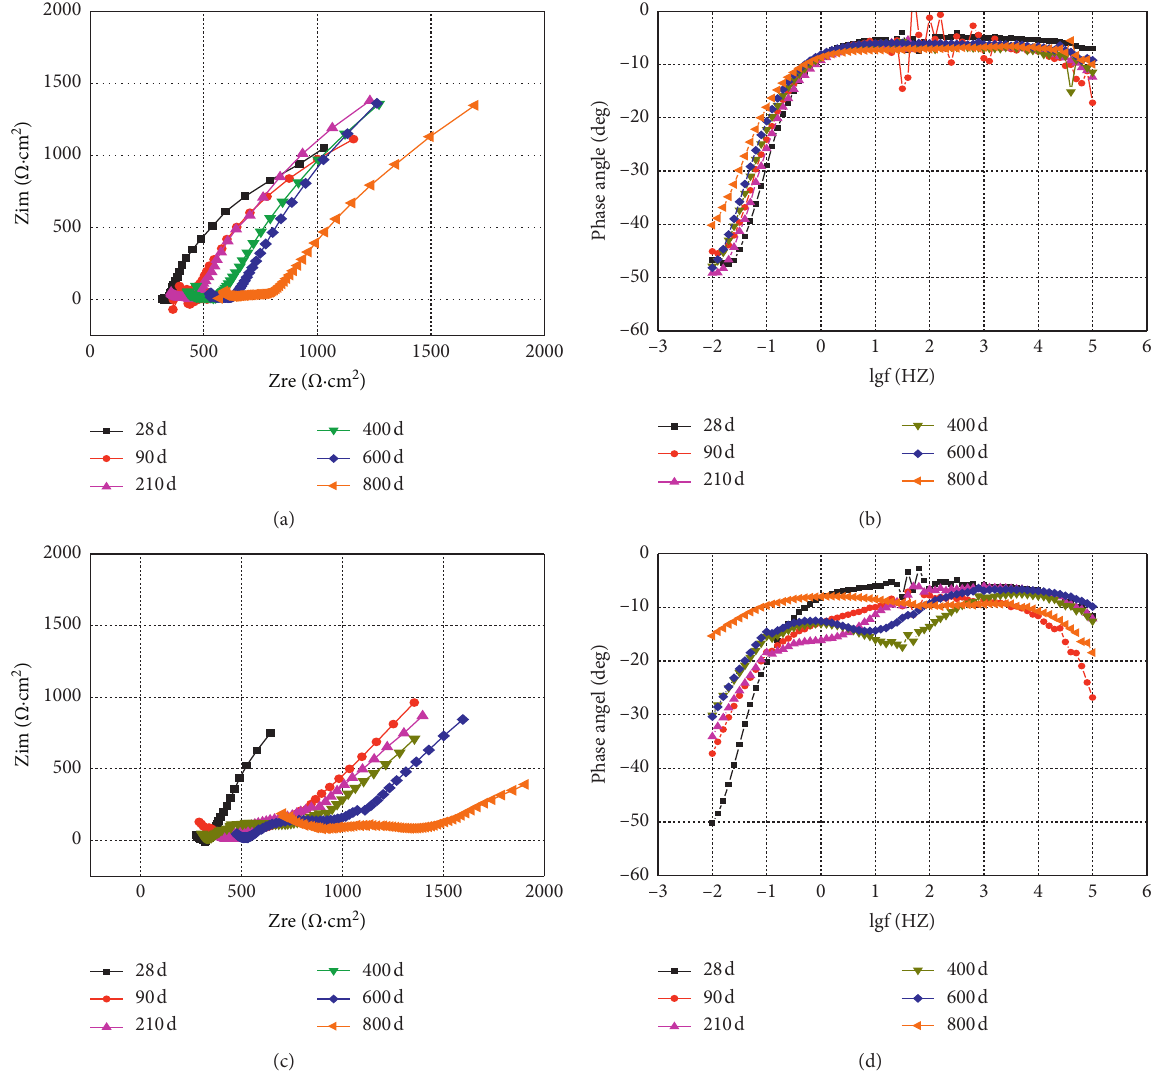
Figure 14: Nyquist and Bode figures of OPC and HPC exposed to submerged zone. (a) Nyquist, OPC. (b) Bode, OPC. (c) Nyquist, HPC. (d) Bode, HPC.